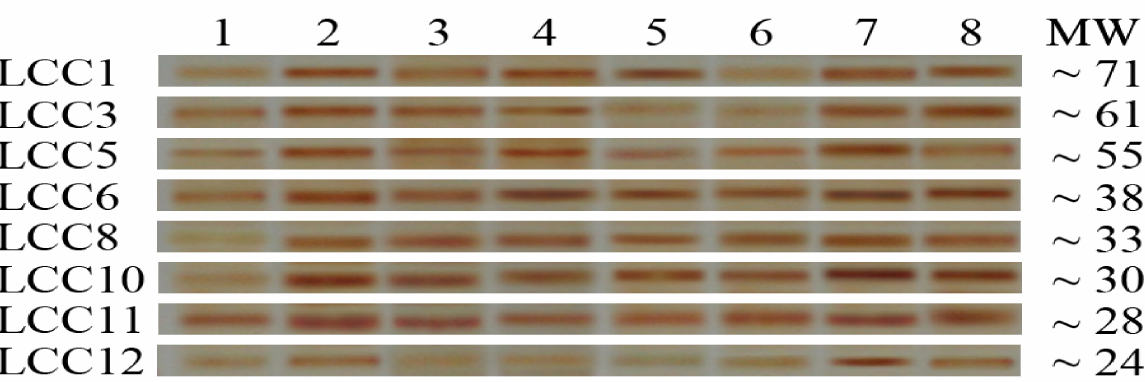
Figure 3. SDS-PAGE of Laccase profile of proteins found in the post-culture liquid of A. terreus KC46206 supplement with crude oil and different inducers after 10 days; 1, control; 2, addition Cu 2+ to culture; 3, Zn 2+ ; 4, ABTS, 5, guaiacol; 6, ferulic acid, 7, Cu − ABTS and 8, Zn-ABTS. The protein molecular marker weights ranging from 66, 45, and 22 kDa was